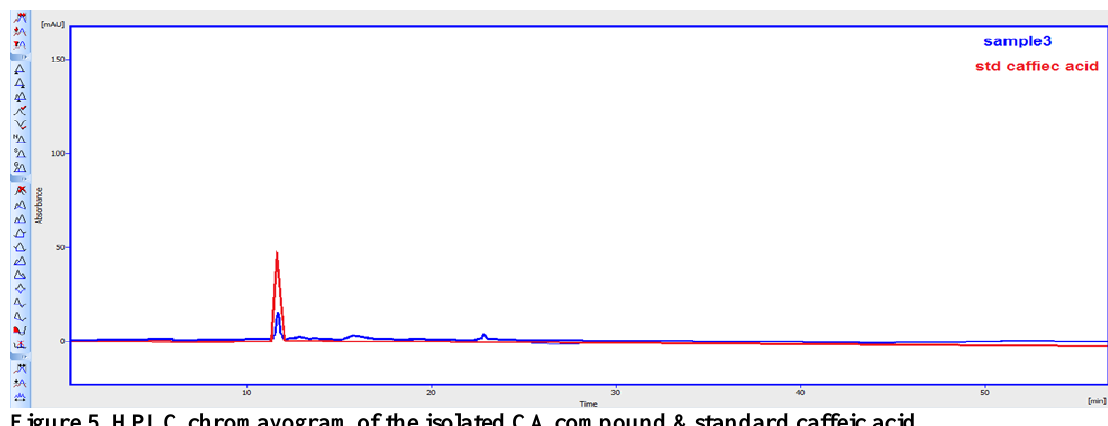
Figure 5. HPLC chromayogram of the isolated CA compound &standard caffeic acid